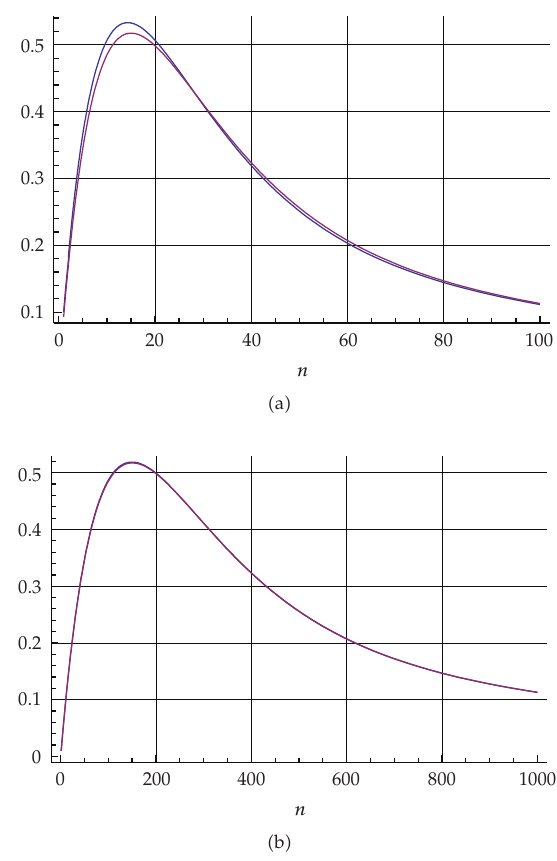
Figure 1: Comparison of G (cid:2) n,p (cid:3) /n as given by (cid:2) 2.6 (cid:3) versus F (cid:2) in blue and red, resp. (cid:3) for p (cid:5) 0 . 1 (cid:2) a (cid:3) and p (cid:5) 0 . 01 (cid:2) b (cid:3) . For p ≤ 0 . 01 the two curves are